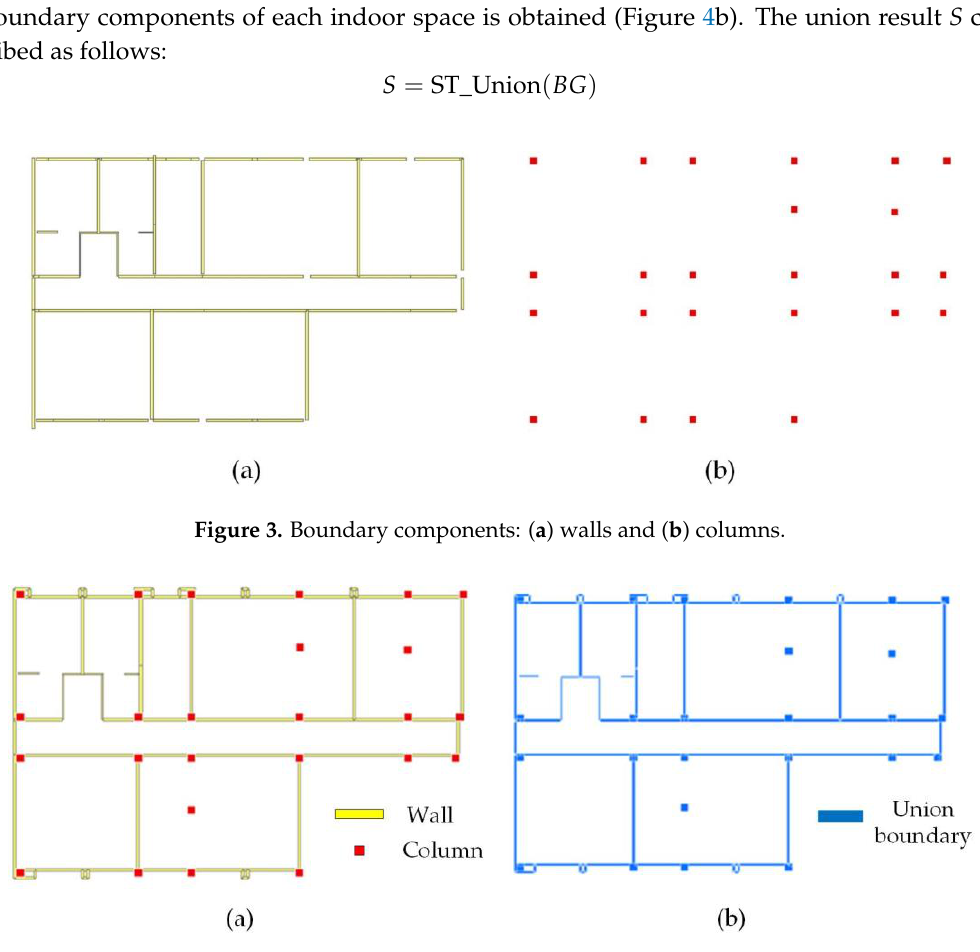
Figure 4. Calculation of the indoor space boundary: ( a ) boundary components of spaces and ( b ) results of the Boolean operation.